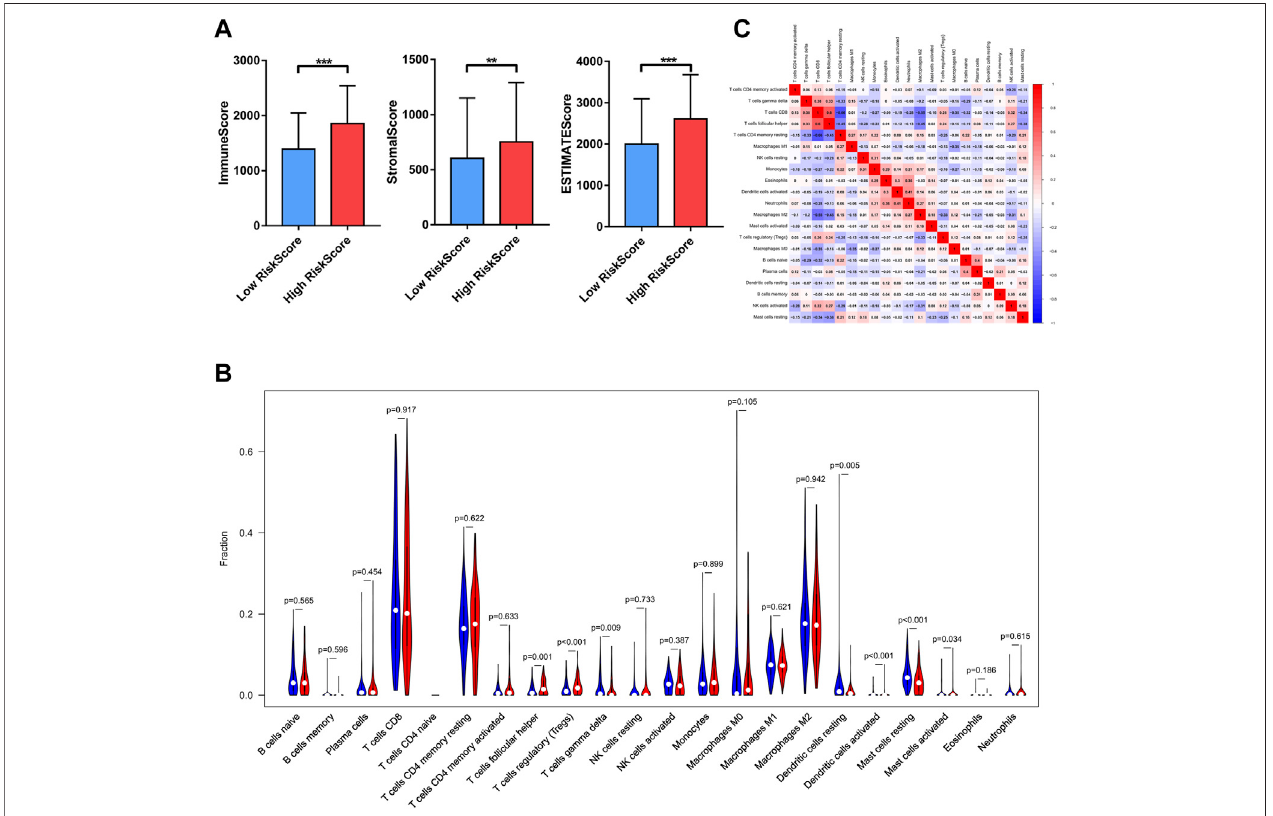
FIGURE6| RelationshipbetweenBu-Meta-GPSandimmunecellin fi ltration. (A) Immunescores,stromalscore,andESTIMATEscoreinhigh-andlow-riskgroups. (B) In fi ltrating levels of 22 immune cell types in high- and low-risk groups. (C) Correlation between the 22 immune cells (* p < 0.05; ** p < 0.01; *** p < 0.001).